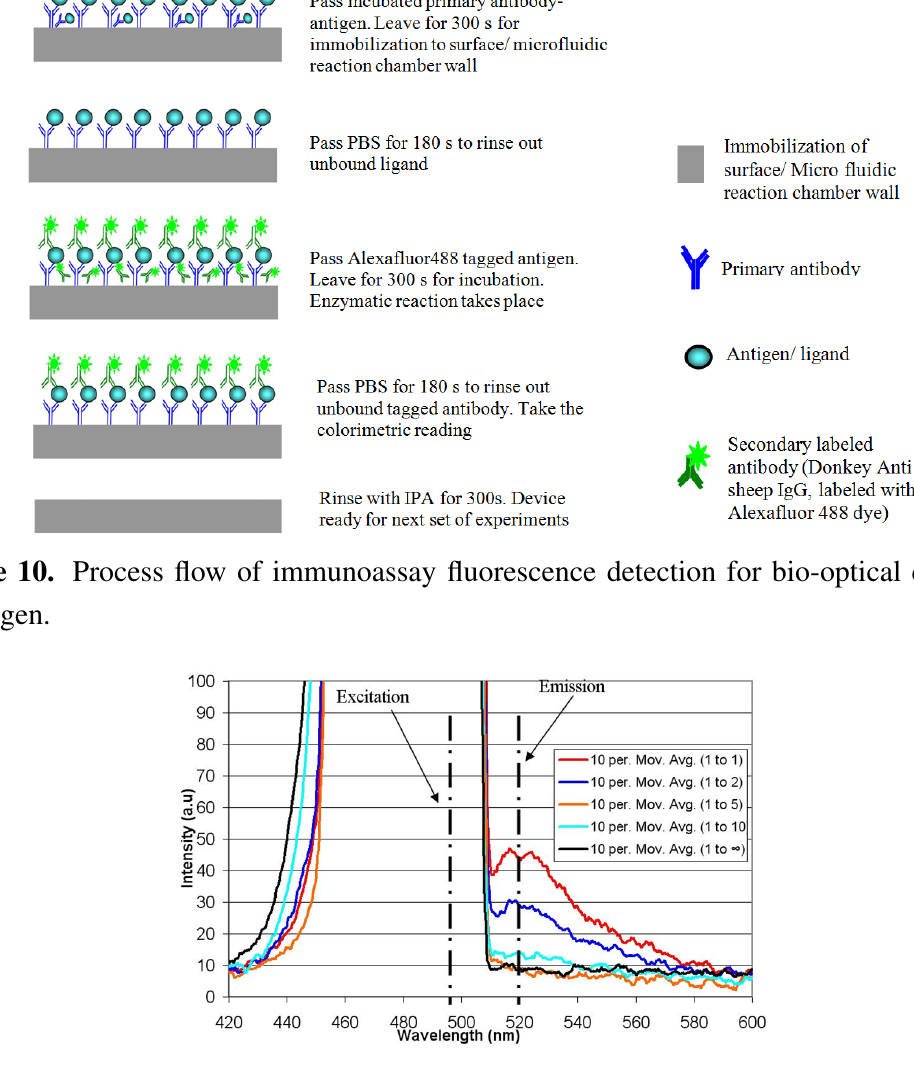
Figure 11. Fluorescence spectral response curve of Alexafluor 488-antibody with sheep IgG at 9 V (zoomed/moving average).